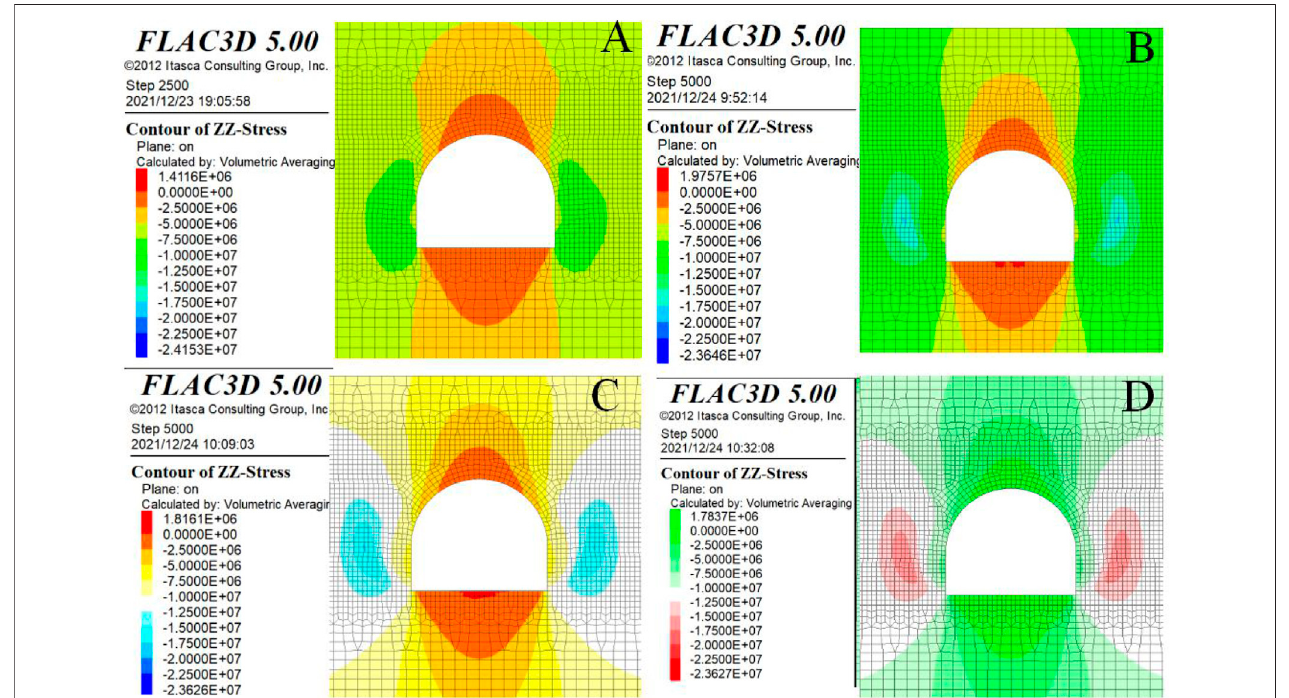
FIGURE 6 | Cloud diagram of ZZ stress distribution. (A) Option 1. (B) Option 2. (C) Option 3. (D) Option 4.